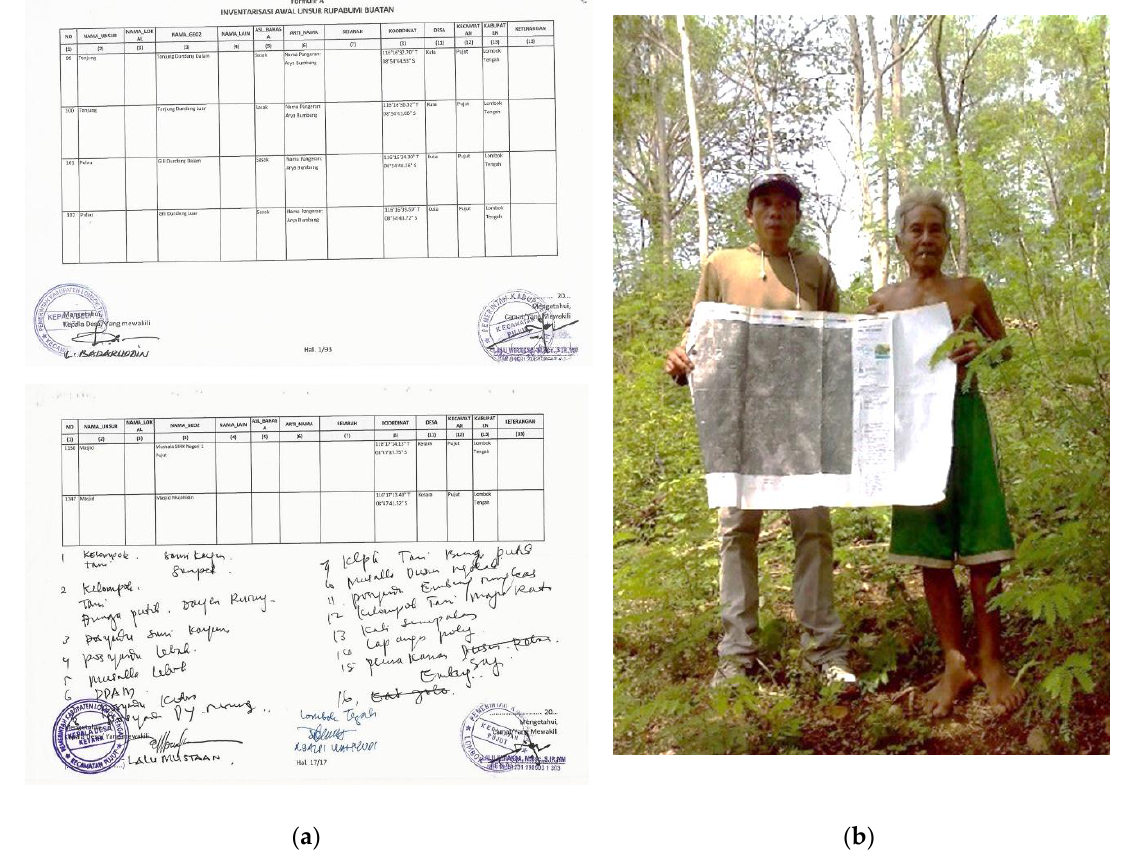
Figure 5. Verification process in the toponymic survey in Lombok: ( a ) compilation of place names with approval from local authority; ( b ) respondents (local people) share their local geographical knowledge and put place names on the map. (Courtesy of Badan Informasi Geospasial)